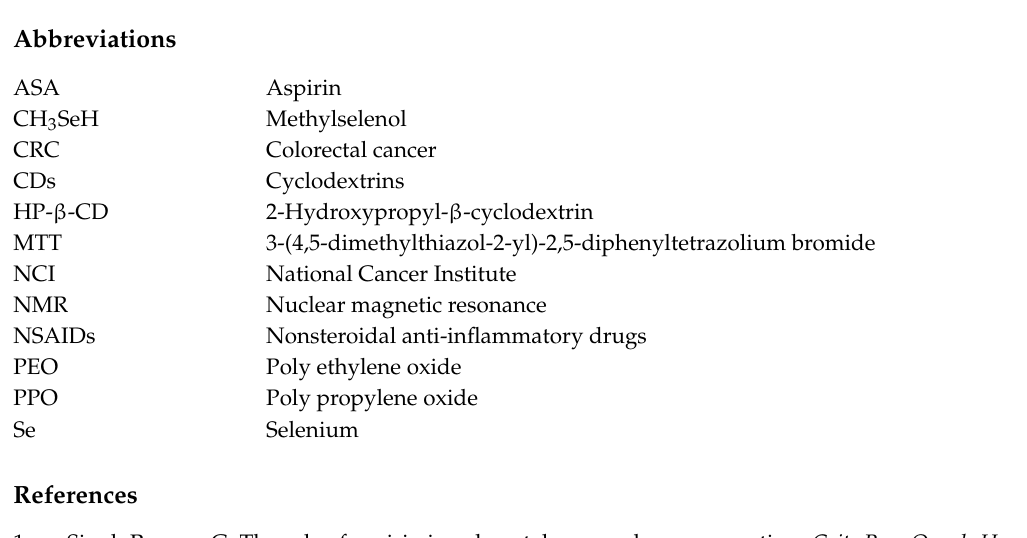
Figure S1. Cell growth of HT-29 cells after treatments with 1a , 1a :HP- β -CD, 1a : β -CD and 1a :F127 at 50 µ M (green), 25 µ M (grey) and 10 µ M (blue) after 24, 48 and 72 h. Cells treated with vehicle (DMSO) located adjacent to the cells treated with 50 µ M (Control A, orange) or 25 µ M (Control B, purple) of 1a or supramolecular structures, were used as controls. Figure S2. 1 H-NMR of 1a . Figure S3. 1 H-NMR of 1a and diclofenac sodium salt. Figure S4. 1 Figure S7. Expanded 1 H-NMR spectra of 1a in the presence of Pluronic F127 (0.1%, 1% and 5% ( w / v )) showing the signal of aryl protons of 1a ( A – C , respectively) at 27 ◦ C (red lines) and 37 ◦ C (blue